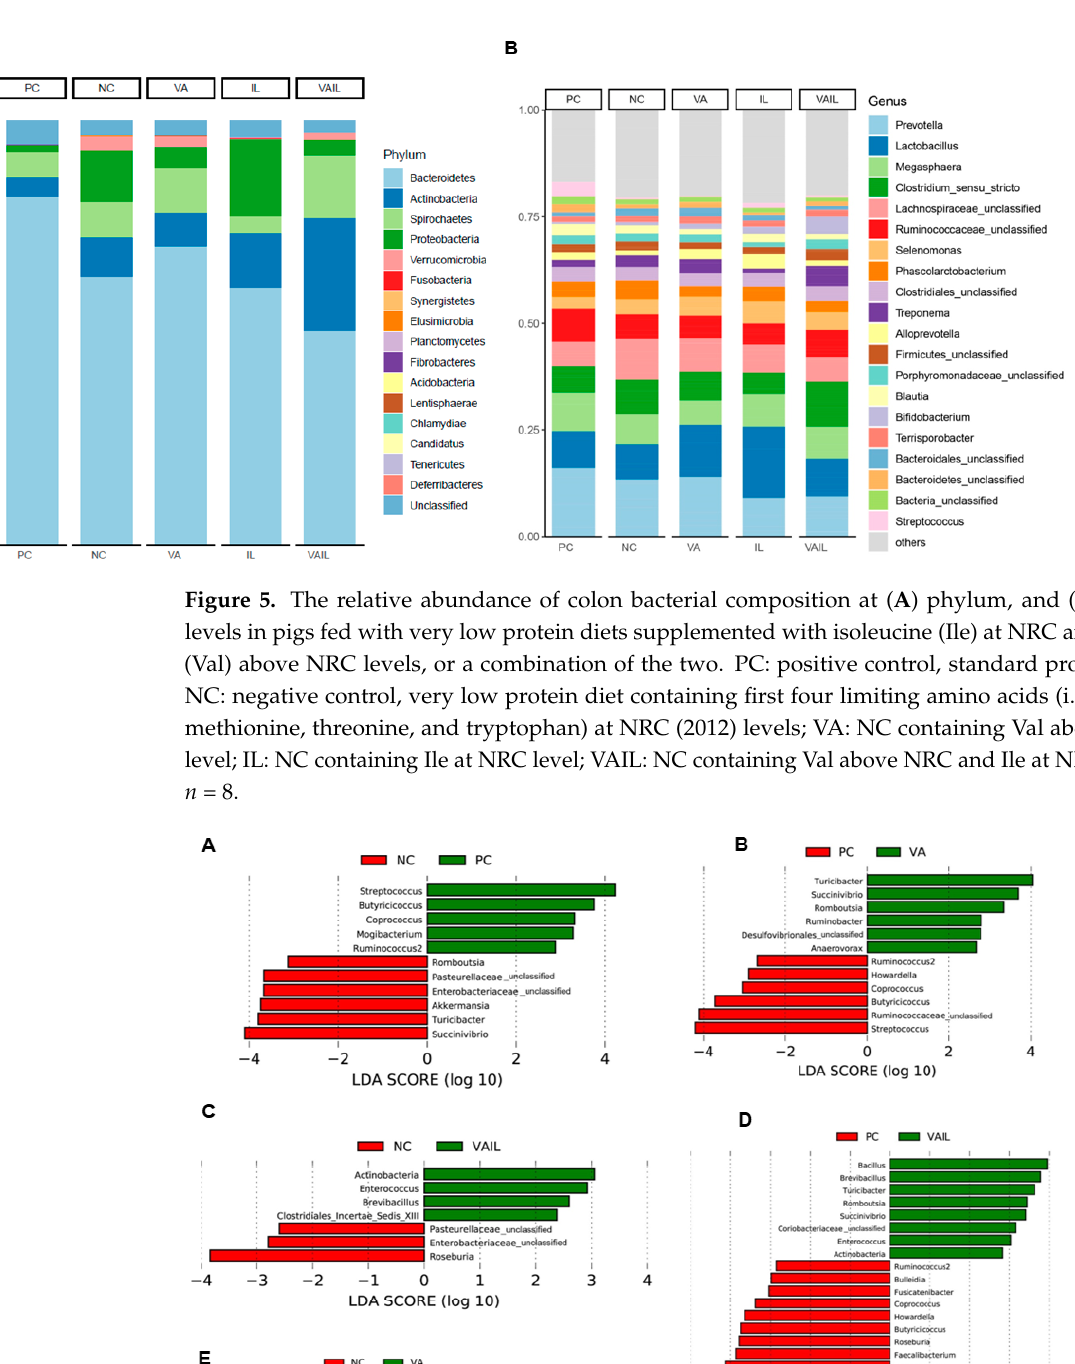
sine, methionine, threonine, and tryptophan) at NRC (2012) levels; VA: NC containing Val above